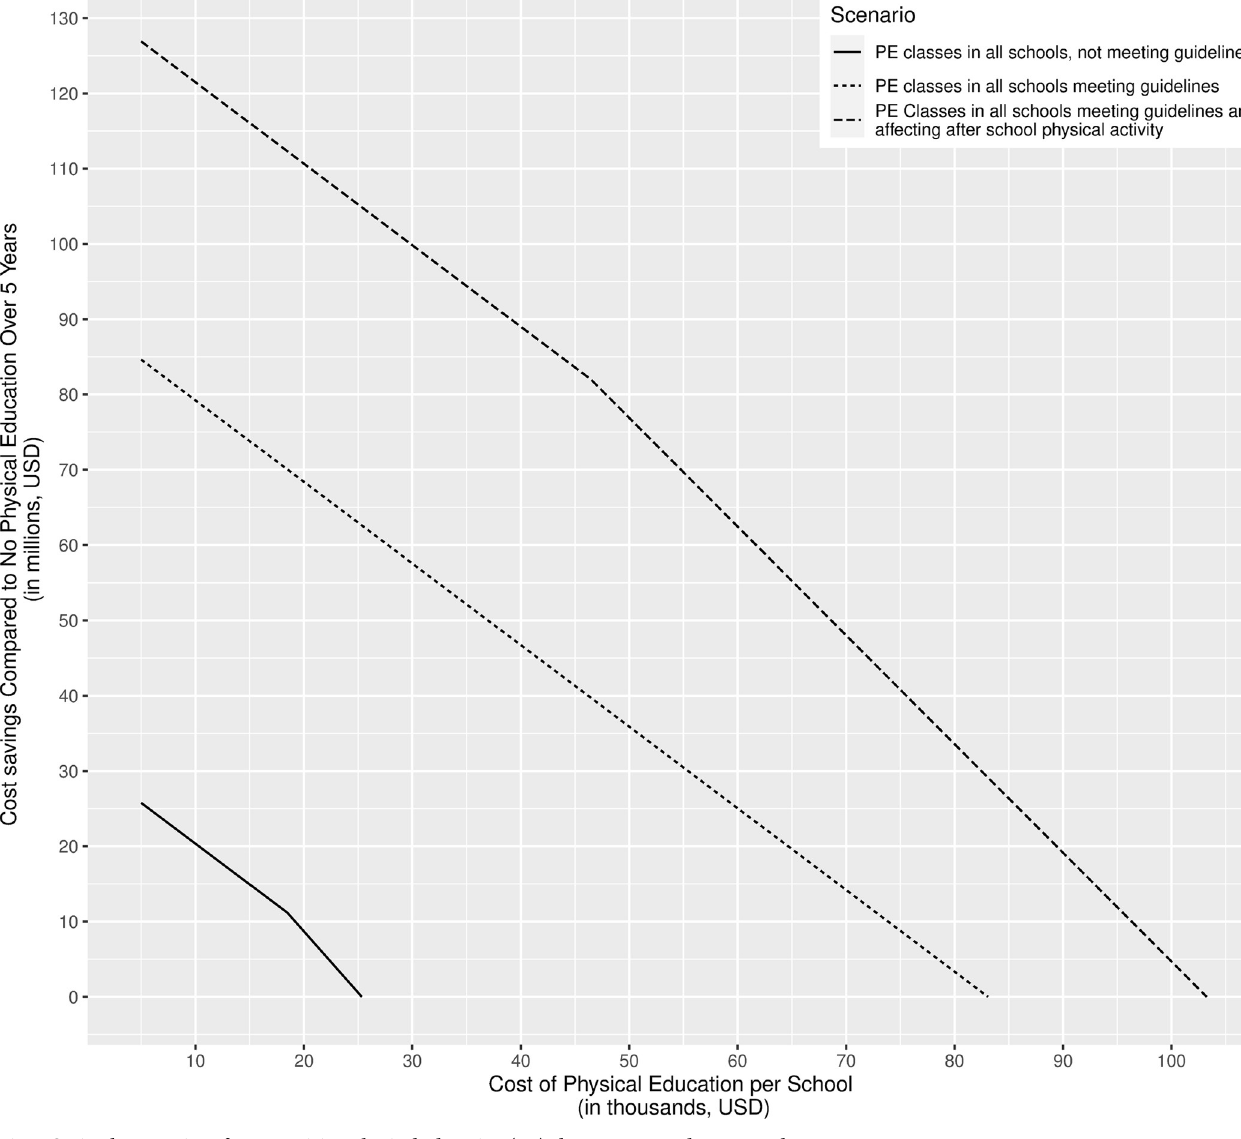
Fig 3. Societal cost savings from requiring physical education (PE) classes compared to no PE classes. When PE classes influenced out-of-school PA, compared to no PE, overweight and obesity prevalence fell by 5.6% (95% CI: 5.3%-5.9%) among males and 6.1% (95% CI: 5.7%-6.5%) among females in the cohort at the end of 5 years. This averted 2,635 cancer cases, 1,389 deaths due to cancer, 1,639 cases of CHD, 187 deaths due to heart attacks, and 395 strokes across the simulated youth population in Mexico City, saving $69.9-$78.3 million in direct medical costs and $81.9-$90.3 million in societal costs, varying with the cost of PE classes ($42.0-$50.3 mil- lion). PE classes could cost up to $101.6 million over the 5 years and still provide cost savings and up to $2.9 billion and still remain cost-effective from the third-party payer perspective ($111.8 million and $2.9 billion, respectively, from the societal perspective).